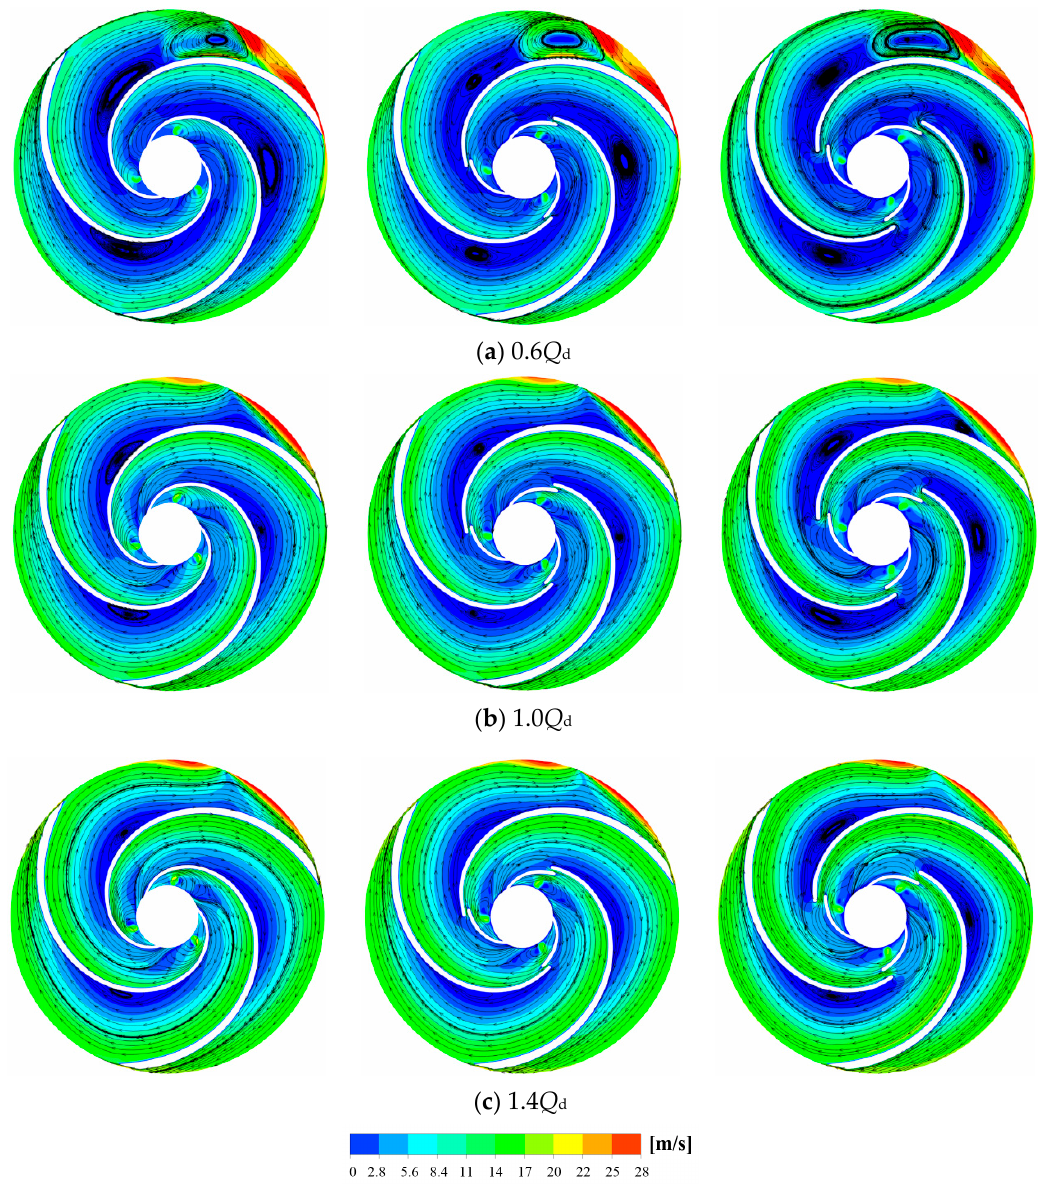
Figure 10. Streamline distribution of middle section of impeller. From left to right: Model 1, Model 2, and Model 3.